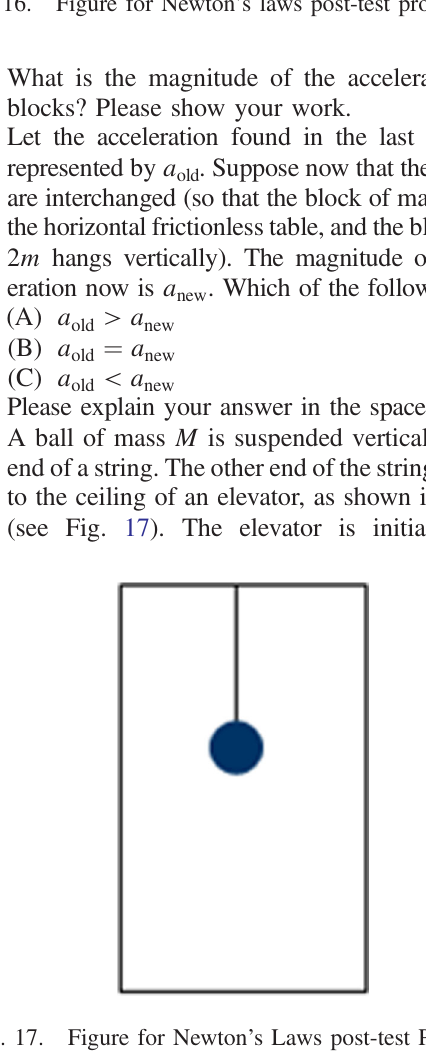
FIG. 16. Figure for Newton ’ s laws post-test problems 4 – 6.